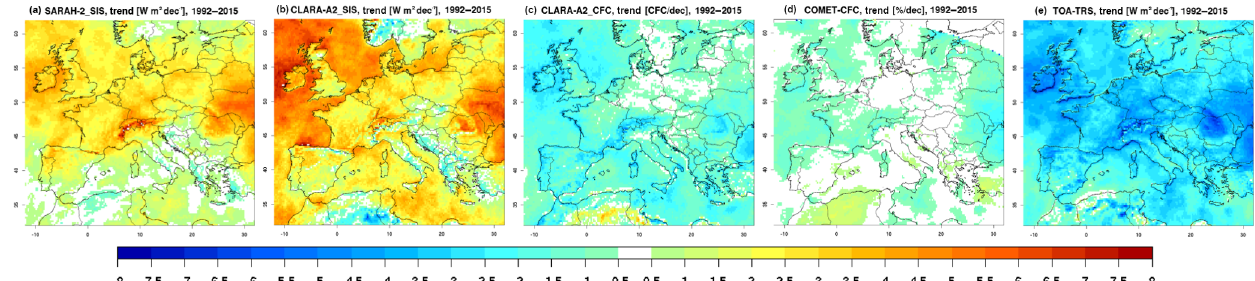
Figure 2. Trends (from left to right) of SARAH-2 SSR [Wm − 2 decade − 1 ], CLARA-A2 SSR [Wm 2 decade − 1 ], CLARA-A2 CFC